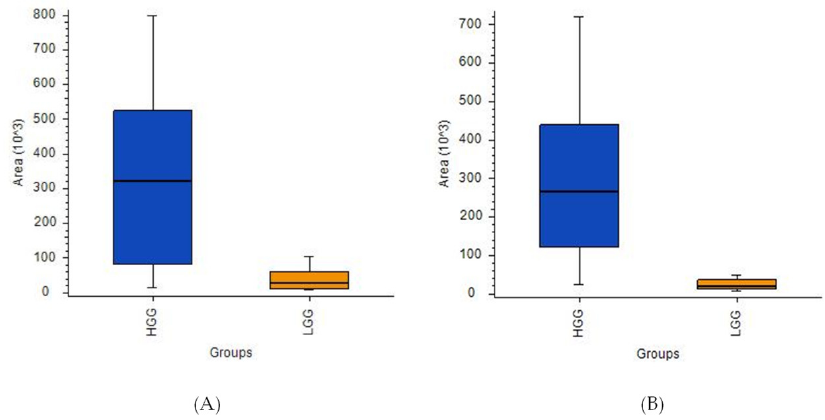
Figure 5. Box-and-whiskers plot for ( A ) L-2-aminoadipic acid and ( B ) propionylcarnitine.